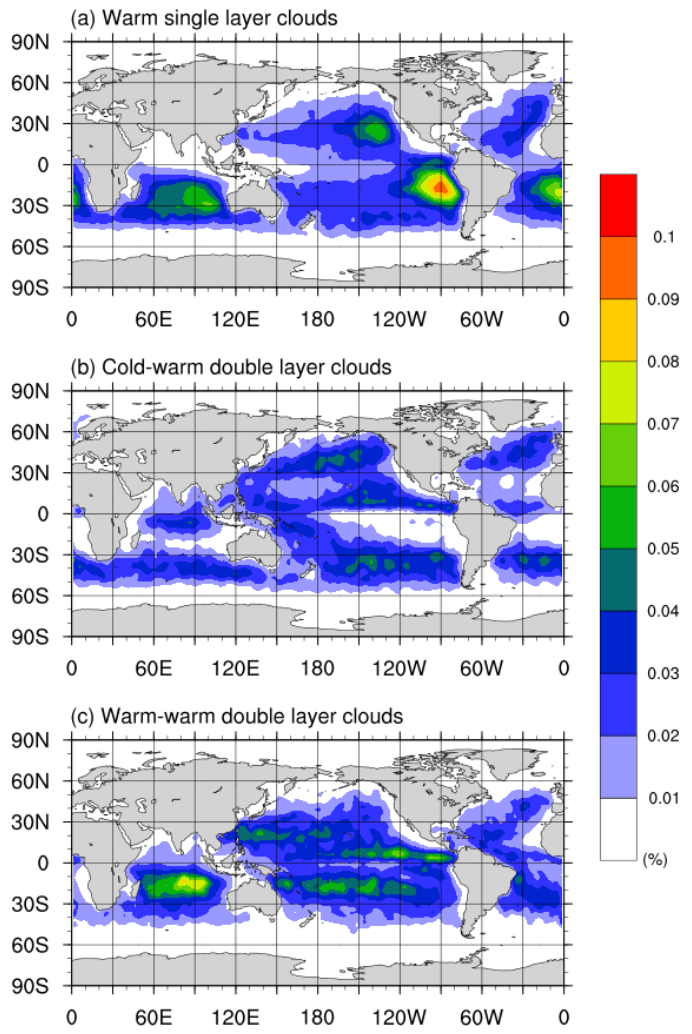
Figure 4. Normalized spatial distribution for warm single layer clouds ( a ), cold-warm double layer clouds ( b ), and warm-warm double layer clouds ( c ). For each panel, the normalization ensures the global sum to be a unit.